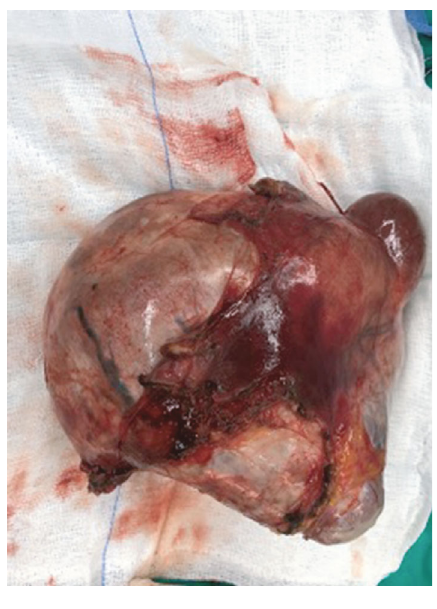
Figure 2: Ovarian teratoma of the left ovary.